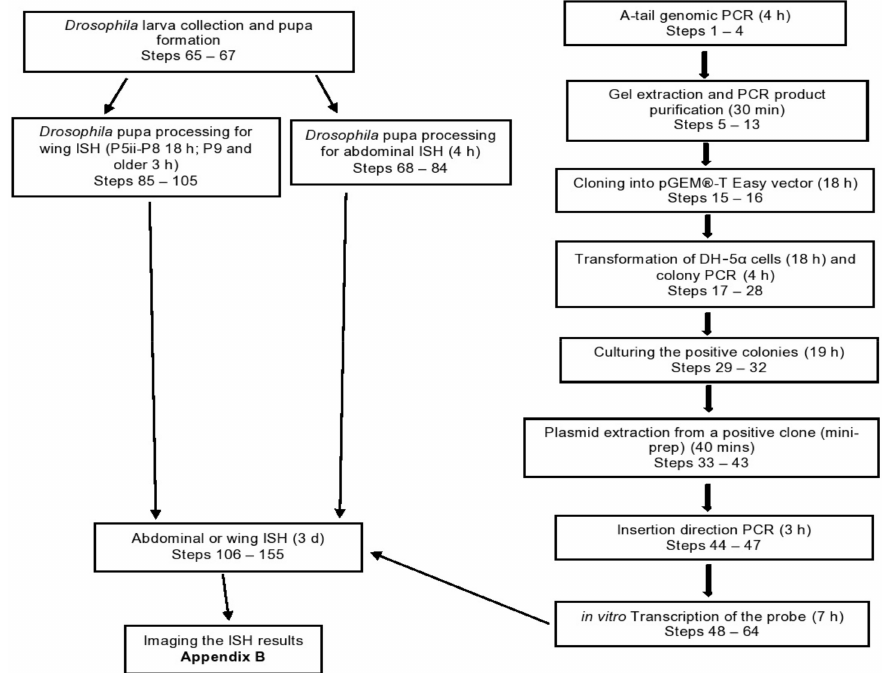
Figure 1. Overview of the ISH procedure in the wings and abdomens of Drosophila species. The major steps are shown sequentially in the boxes linked by arrows. The duration of each step is indicated in parentheses inside the boxes. Boxes on the right side describe the probe preparation steps, and boxes on the left side illustrate the sample preparation and ISH